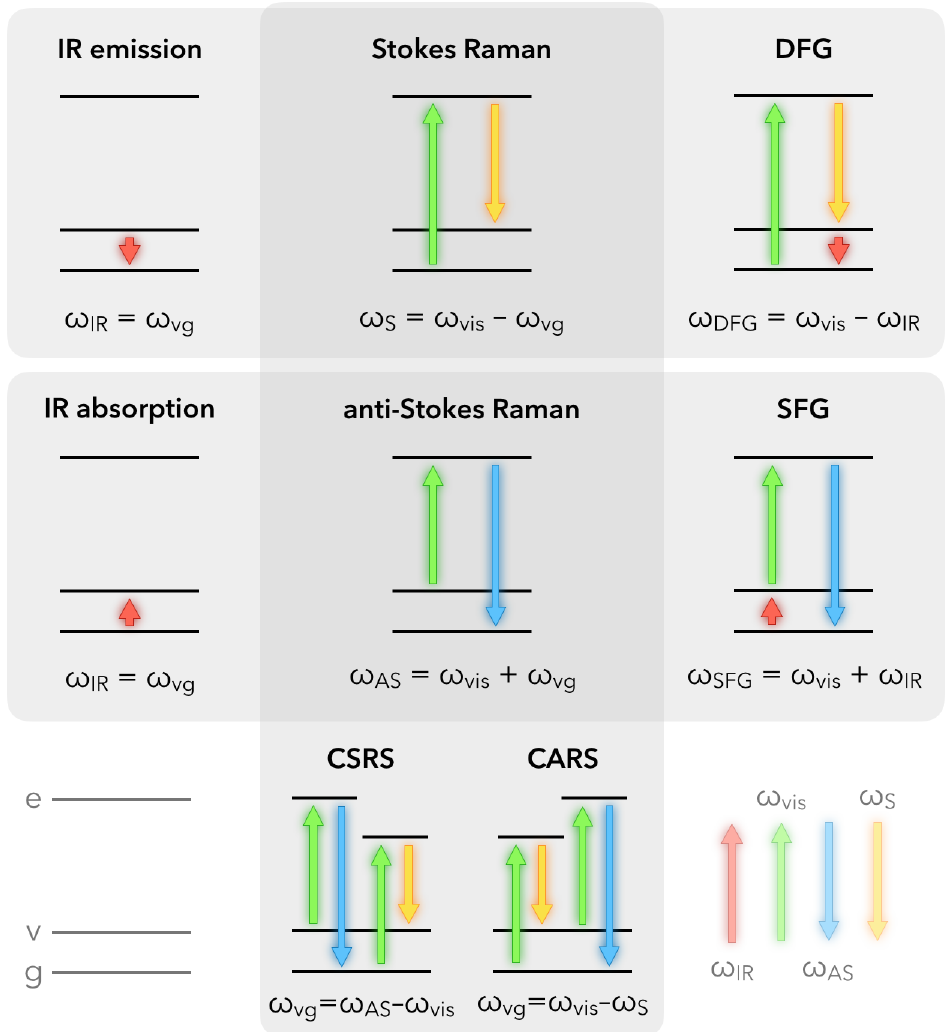
Figure 1. Molecular energy diagrams used for IR, Raman, SFG/DFG and CARS/CSRS spectroscopy. SFG = Sum-Frequency Generation; DFG = Difference-Frequency Generation; CARS = Coherent Anti-Stokes Raman Scattering; CSRS = Coherent Stokes Raman Scattering; S = Stokes; AS = Anti-Stokes; Energy level code: e = virtual electronic state, v = vibrational state, g = ground